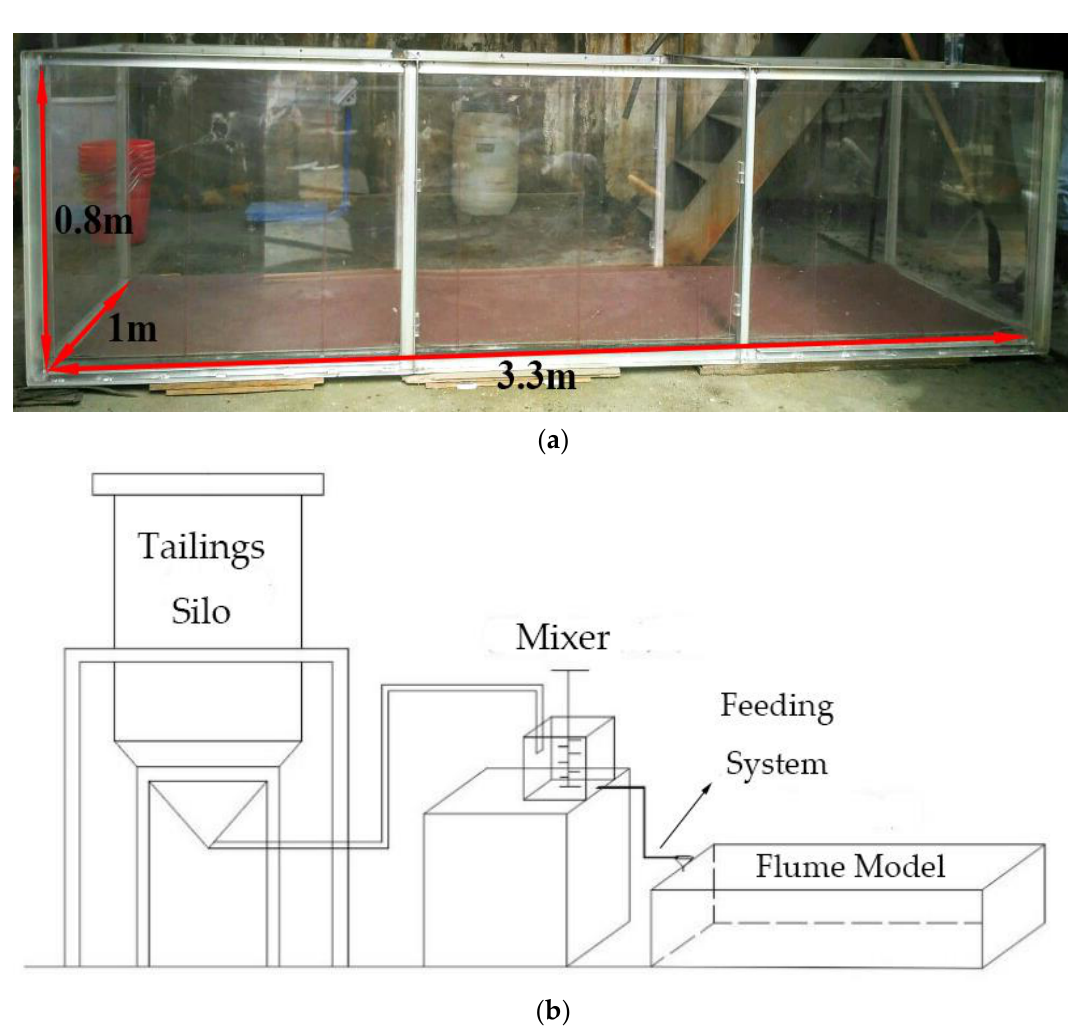
Figure 1. Diagram of the flume model test system. ( a ) Picture of the flume model; ( b ) the components of the test system.